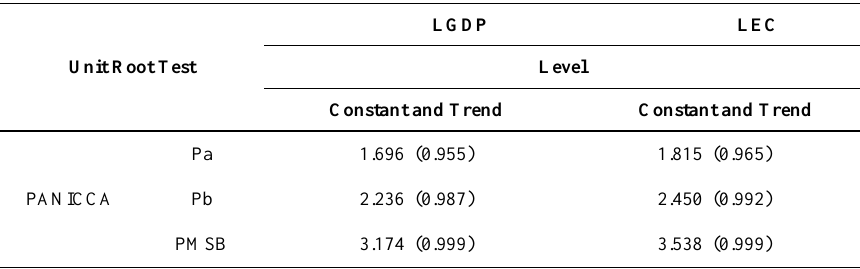
Table 4. Unit Root Test Results